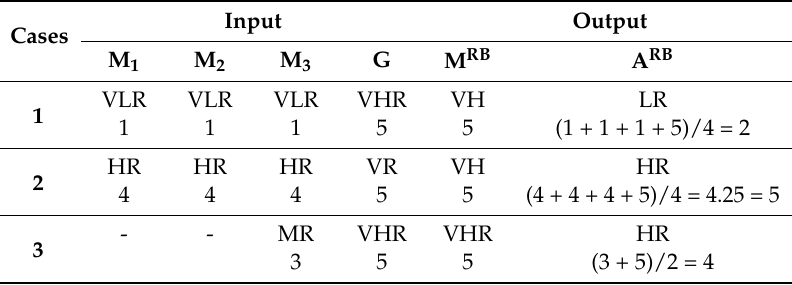
Table 3. Example cases for illustration of rules specification using A RB and M RB schemes.